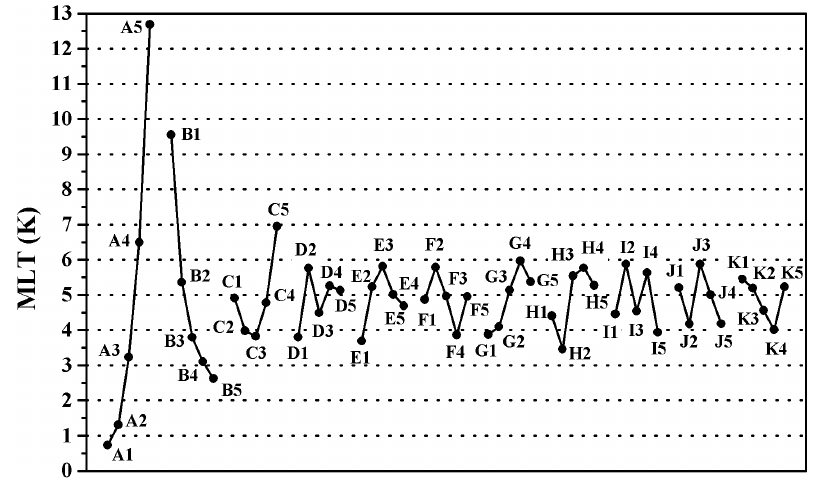
Figure 4. Influence of factors on the maximum local temperature-rise (MLT) for a set of 50 models defined by the orthogonal array (OA)